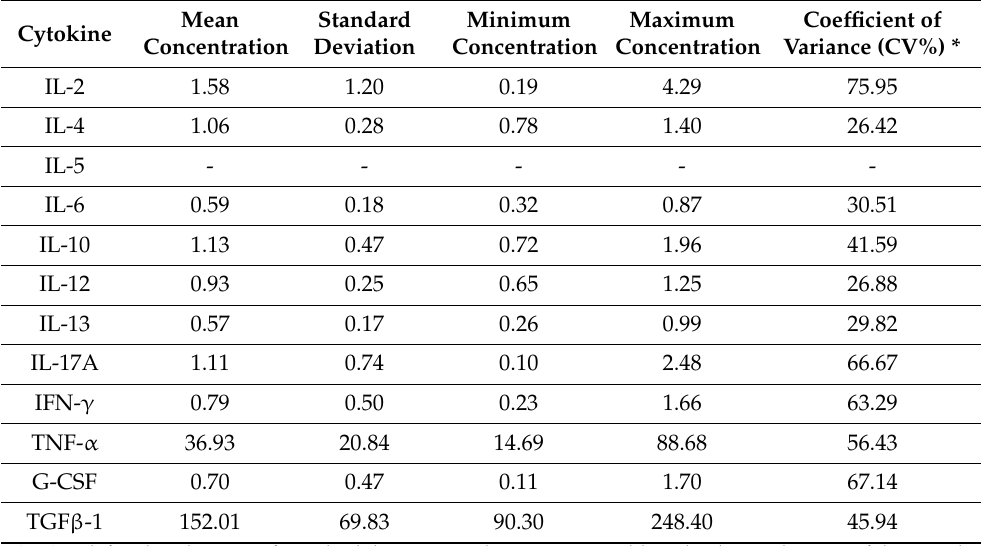
Table 2. Mean concentration and Coefficient of Variation (CV%) of the cytokines in pg/mL. Mean Standard Minimum Maximum Coefficient of Cytokine Concentration Deviation Concentration Concentration